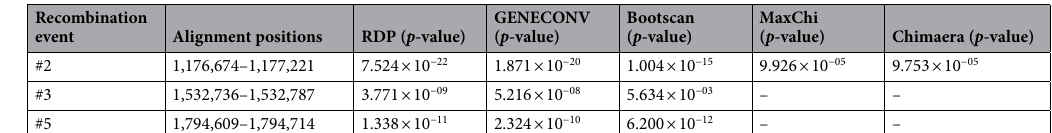
Table 5. Statistical values associated with different algorithms implemented in RDP4 for the confirmed recombination events.